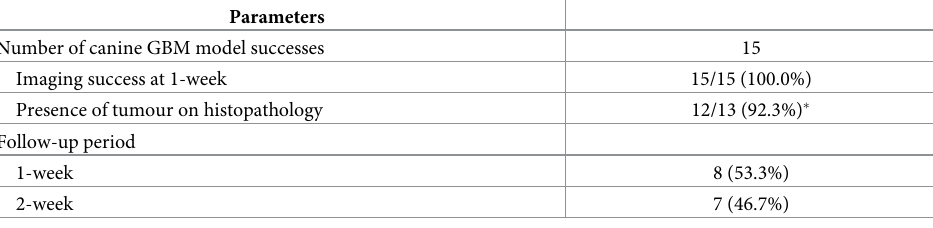
Table 1. Canine experimental glioblastoma multiforme model